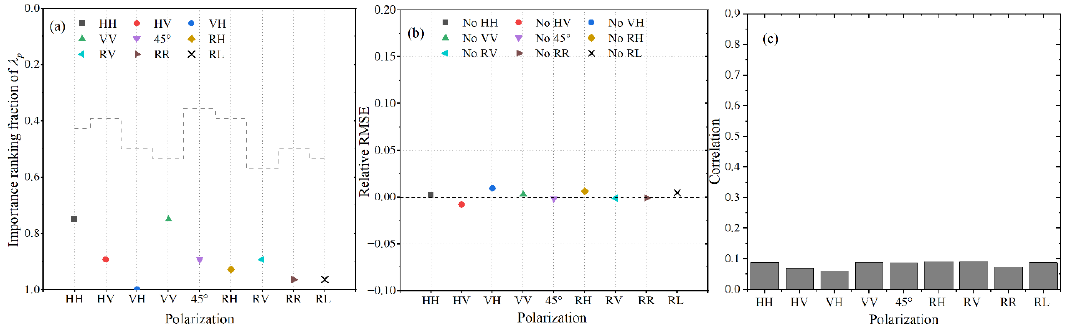
Figure 22. The importance of λ p to SWH retrieval from single-polarization models. ( a ) The importance ranking of λ p provided by XGBoost models normalized to 0–1. The dotted line represents the optimal feature sets under different polarizations. ( b ) The effect of removing λ p on the SWH estimation from different polarized models. Different markers in various colors represent λ p of different polarizations. ( c ) The correlation between λ p and ERA5 SWH under different polarizations.